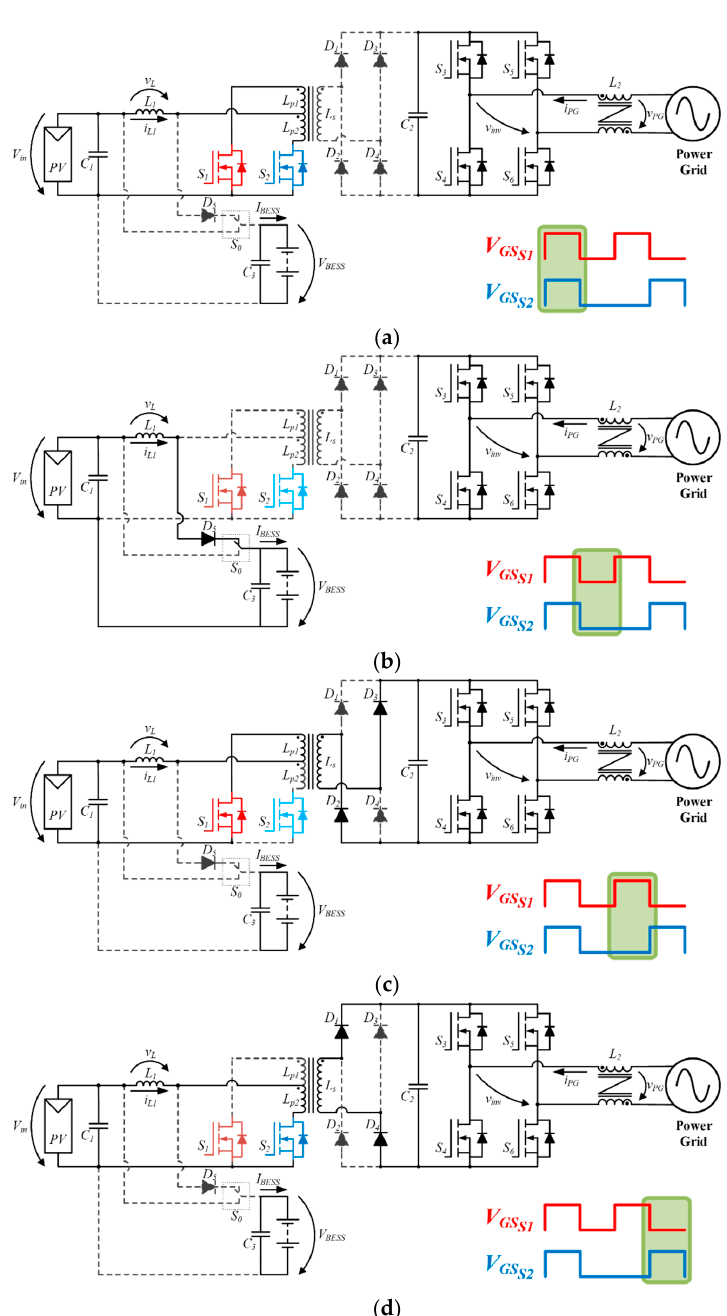
Figure 3. Operation states of the microinverter for the first three modes: ( a ) metal–oxide–semiconductor field-effect transistor (MOSFET) S 1 and S 2 turned-on, creating a magnetic short-circuit into the high frequency transformer; ( b ) MOSFET S 1 and S 2 turned-off, charging the battery energy storage system (BESS); ( c ) Only MOSFET S 1 is turned-on, sending energy to the secondary winding of the transformer by L p 1 ; ( d ) Only MOSFET S 2 is turned-on, sending energy to the secondary winding of the transformer by L p 2 .